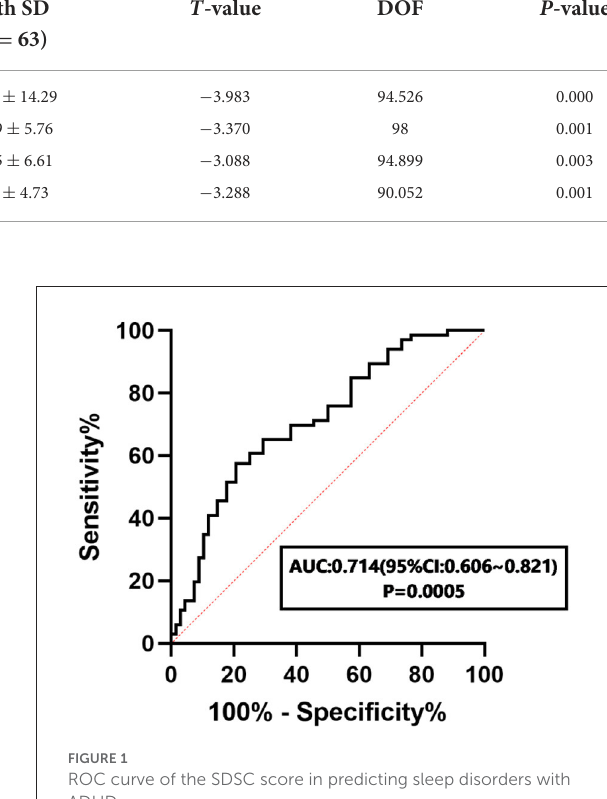
FIGURE1 ROC curve of the SDSC score in predicting sleep disorders with